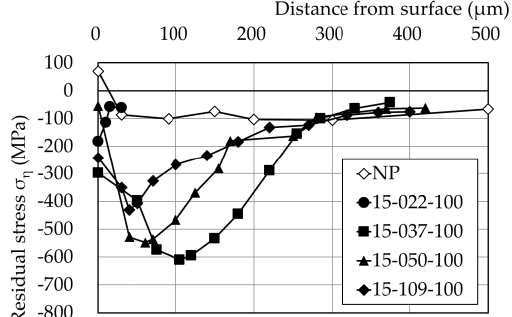
Figure 7. Residual stress depth distribution (15 mJ).